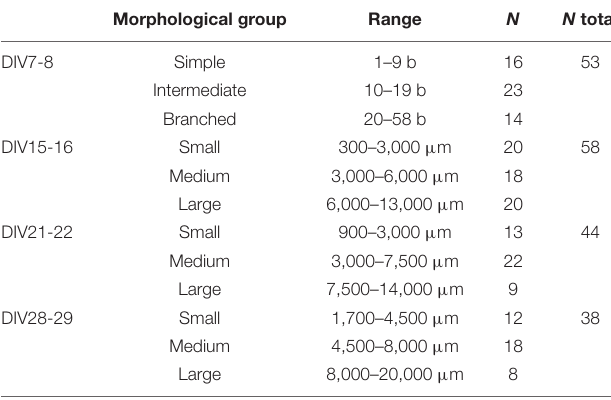
TABLE 3 | Morphological groups of neurons identified during cultivation of spinal cord cultures. Morphological group